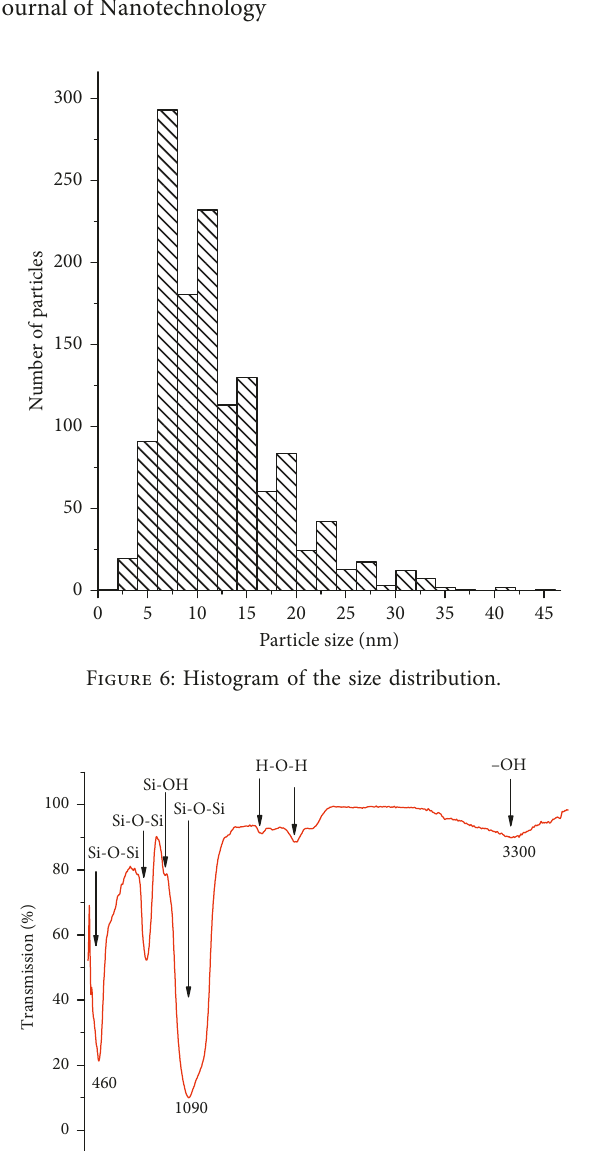
x O y @F-synthesized